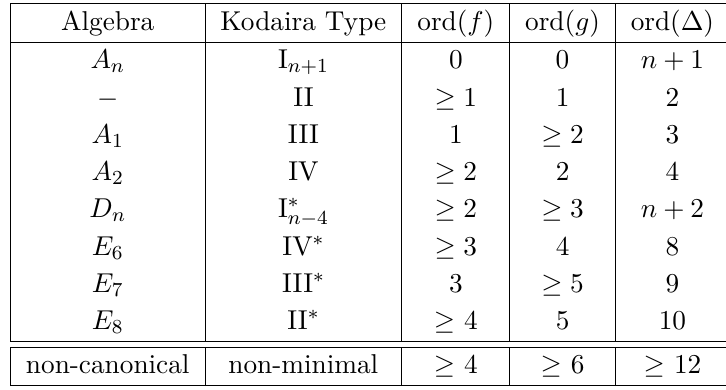
Table 1 . Kodaira table of vanishing orders for a Weierstrass model of a K3